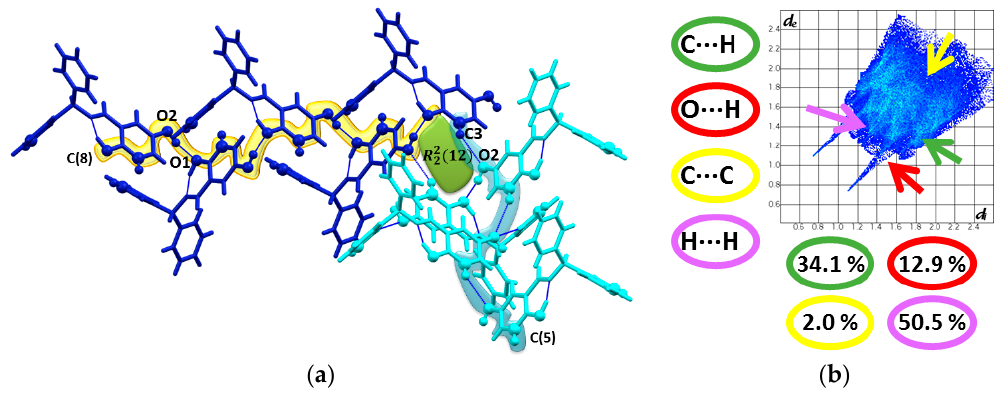
Figure 5. View of ( a ) chains of pOHsaladpm molecules formed by means of O–H···O and C–H···O interactions and ( b ) the 2D-fingerprint plot with marked corresponding regions: green arrow for C···H contacts, red arrows for O···H contacts, yellow arrow for C···C contacts and violet arrow for H···H contacts. mvanadpm crystallizes in the P 2 1 / c space group of the monoclinic system with four molecules